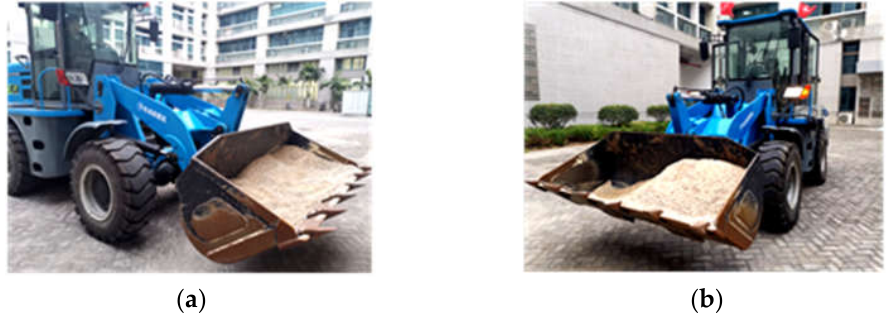
Figure 9. Pictures of the materials in the bucket under normal load and offset load conditions. ( a ) Normal load condition; ( b ) Offset load condition.